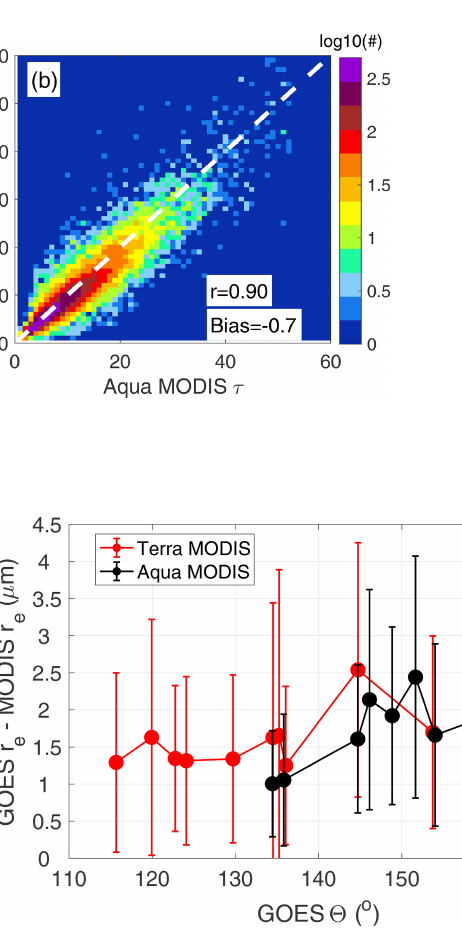
Figure 10. r e differences between GOES-13 and Terra MODIS (red) and Aqua MODIS (black) binned in deciles of GOES-13 scat- tering angle ( (cid:50) ). Error bars represent the root mean square differ- ence for each